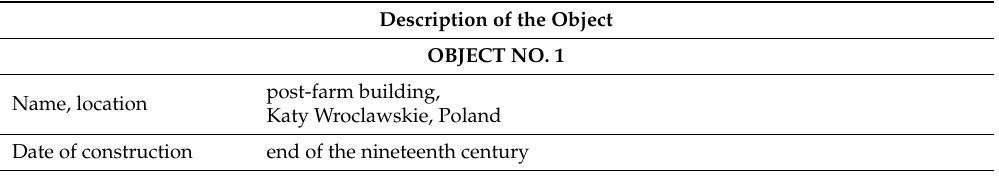
Table 1. Characteristics of the facilities where the tests were conducted for the purpose of verifying the artificial neural